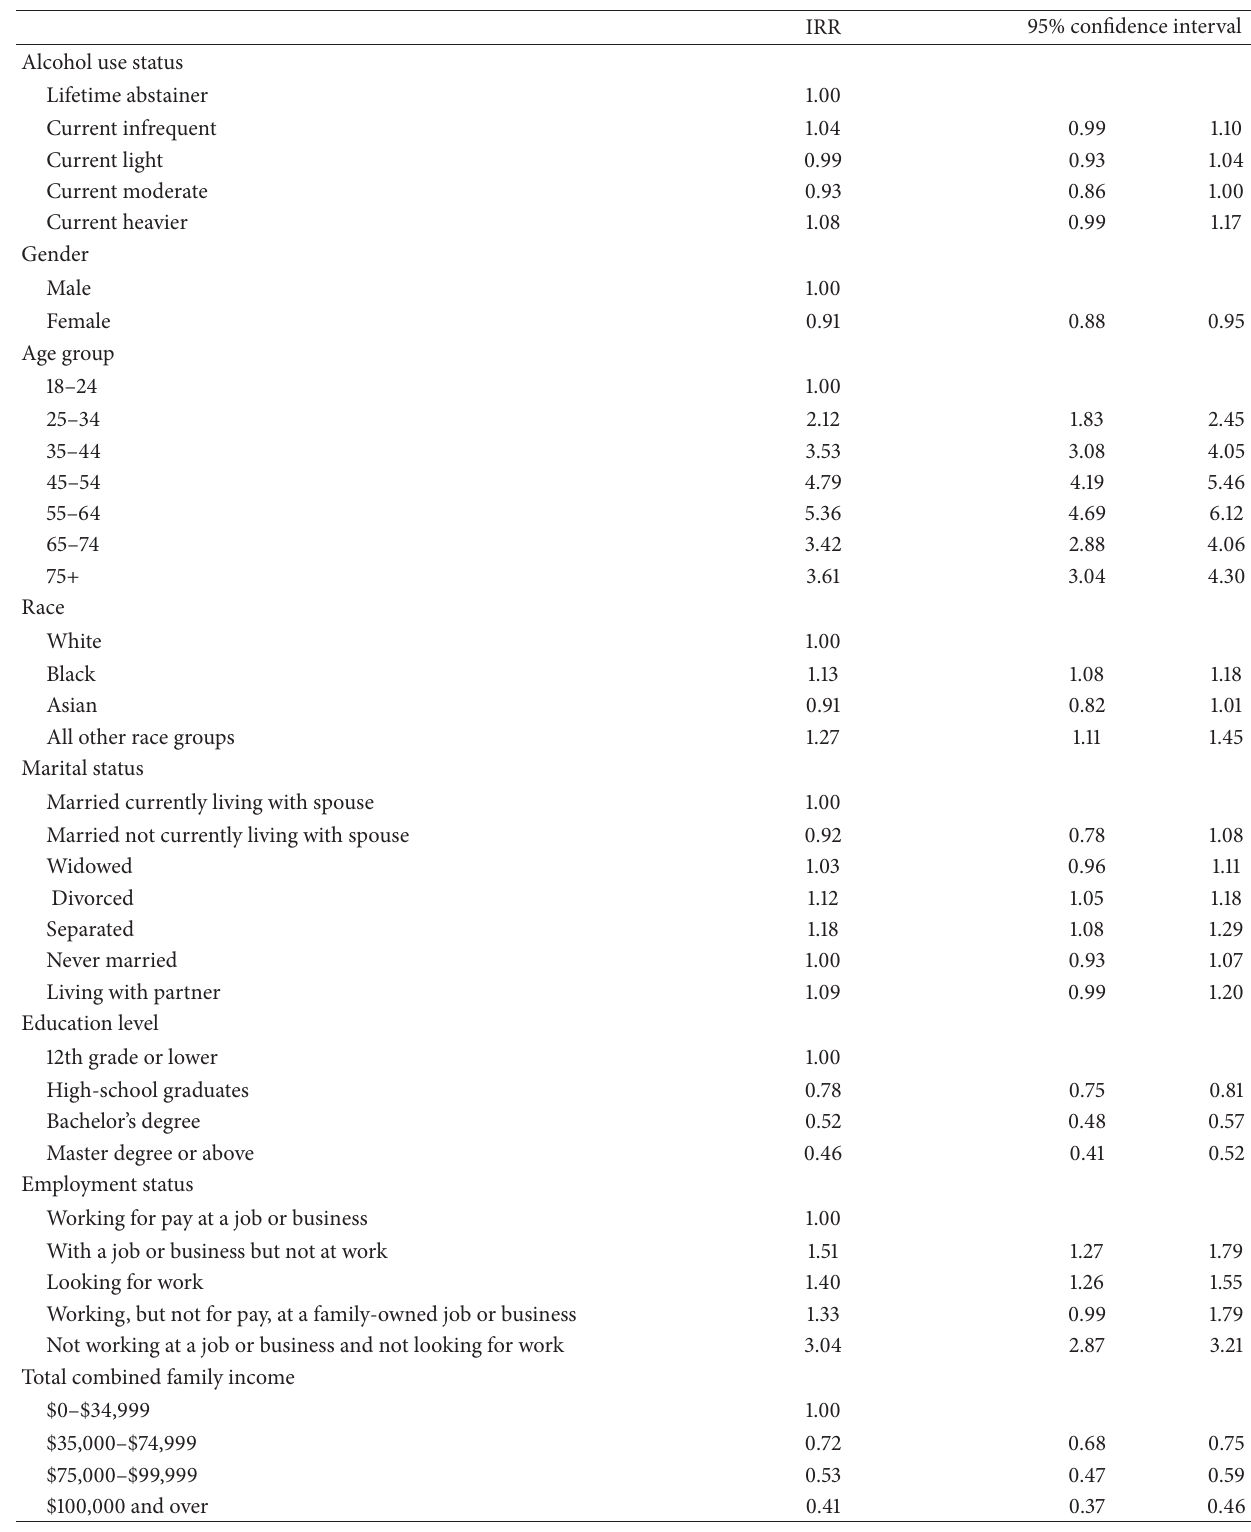
Table 6: Association between alcohol use and health status using the traditional approach plus offsetting for residual confounding effects and intention-to-treat analysis (RR: relative